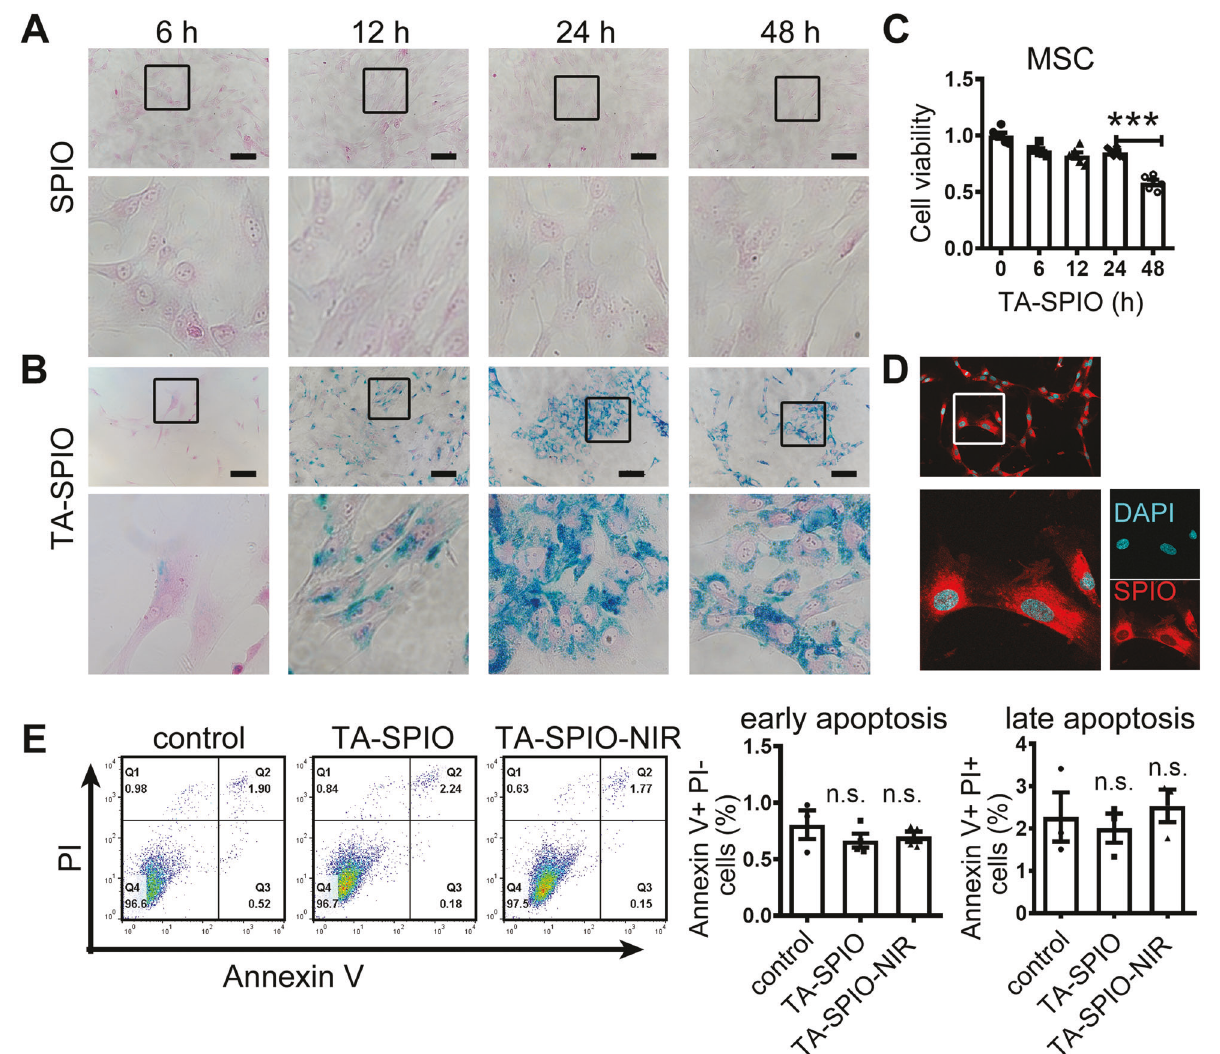
Fig. 1 Characterization of MSCs and MSC SPIO . A , B Prussian-blue staining of MSCs treated with A SPIO alone, or B SPIO and transfection agent. C MSCs were treated with SPIO and transfection agent, cell viability was measured by CCK-8 assay. D MSCs were treated with SPIO-NIR and transfection agent for 24 h, the fl uorescence intensity was measured by confocal microscope. E Cell apoptosis was determined by fl ow cytometry. Data are shown as mean ± SEM ( n = 3). *** p < 0.001. TA transfection agent (Superfect,